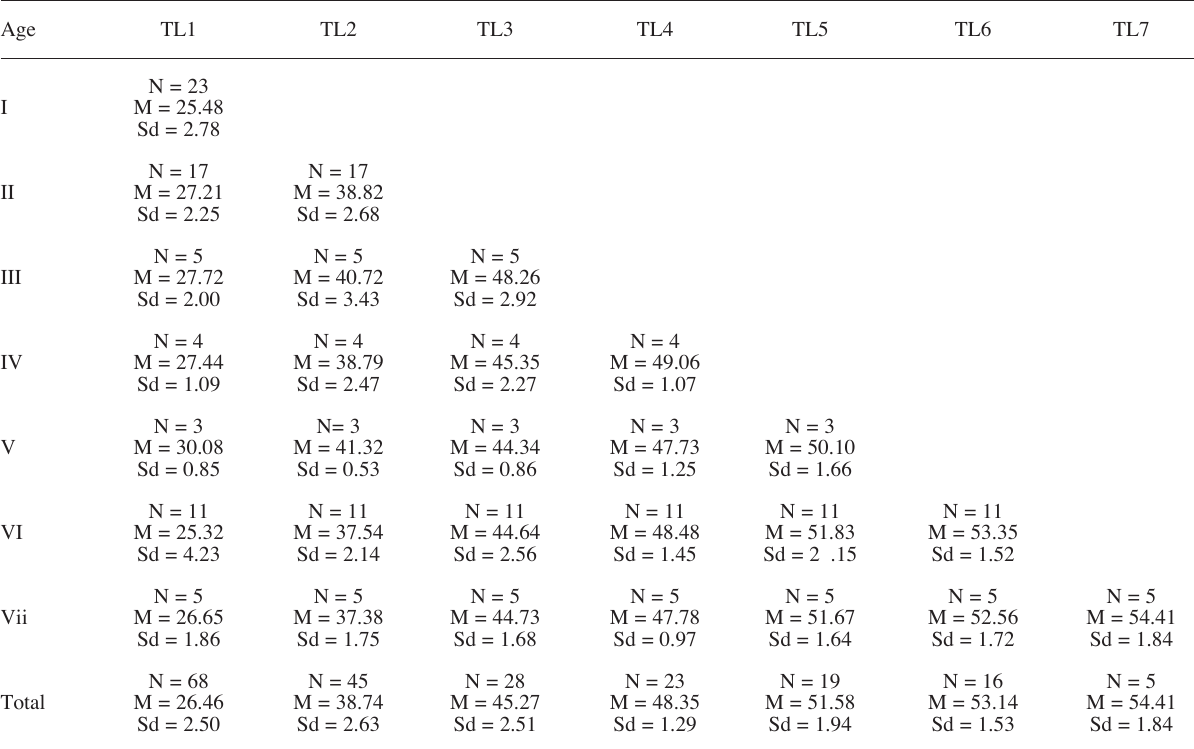
F IG . 1. – Monthly evolution of the marginal increment (MI =R–R R –R , where R and R are the radius of the last and the next-to- n n-1 n n-1 last growth rings respectively) of scales of gilthead seabream in Mellah lagoon, Algeria. The different letters indicate significant differences between sampling